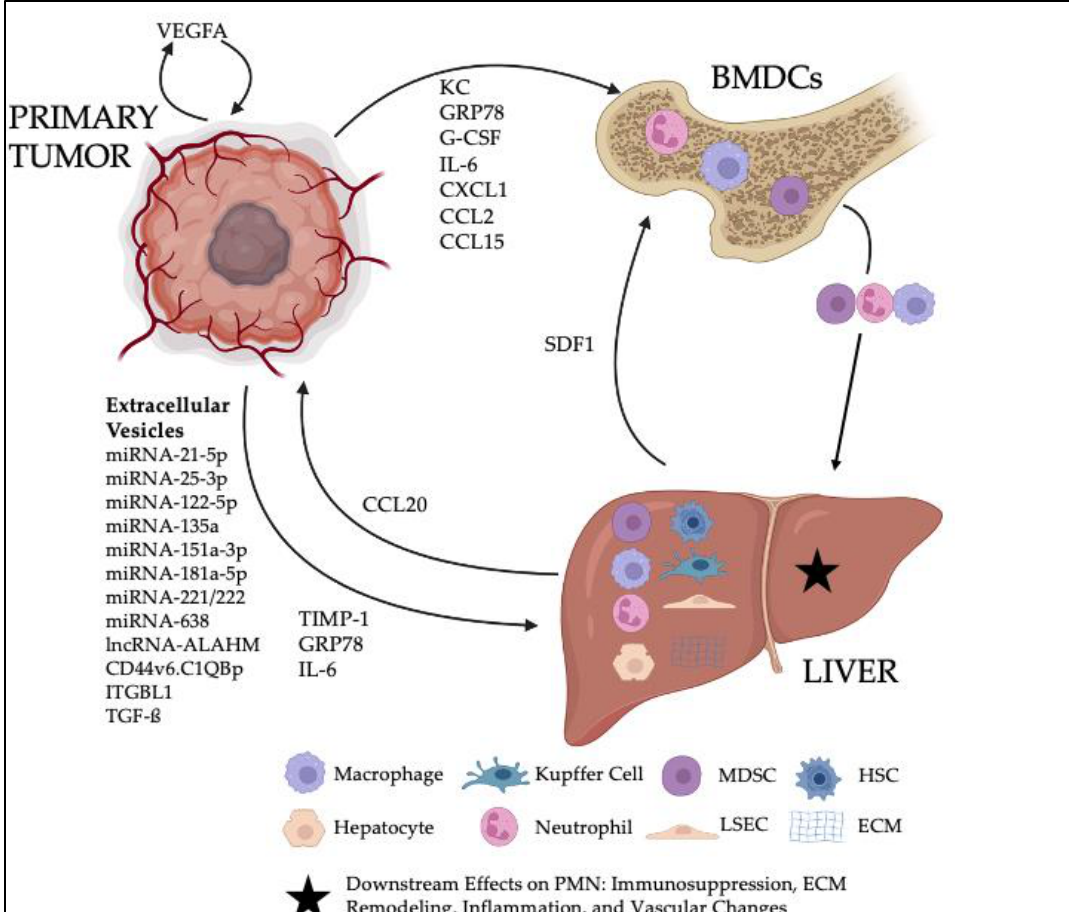
Figure 1. Scheme demonstrating the tissues, cells, messengers, and changes involved in orchestrating the hepatic PMN. The primary tumor secretes molecular communicators into circulation, which interact with bone marrow immune populations as well as directly with resident cells in the liver. The resulting interactions among all these components is a set of characteristic changes that define the development of the PMN and facilitate susceptibility to downstream